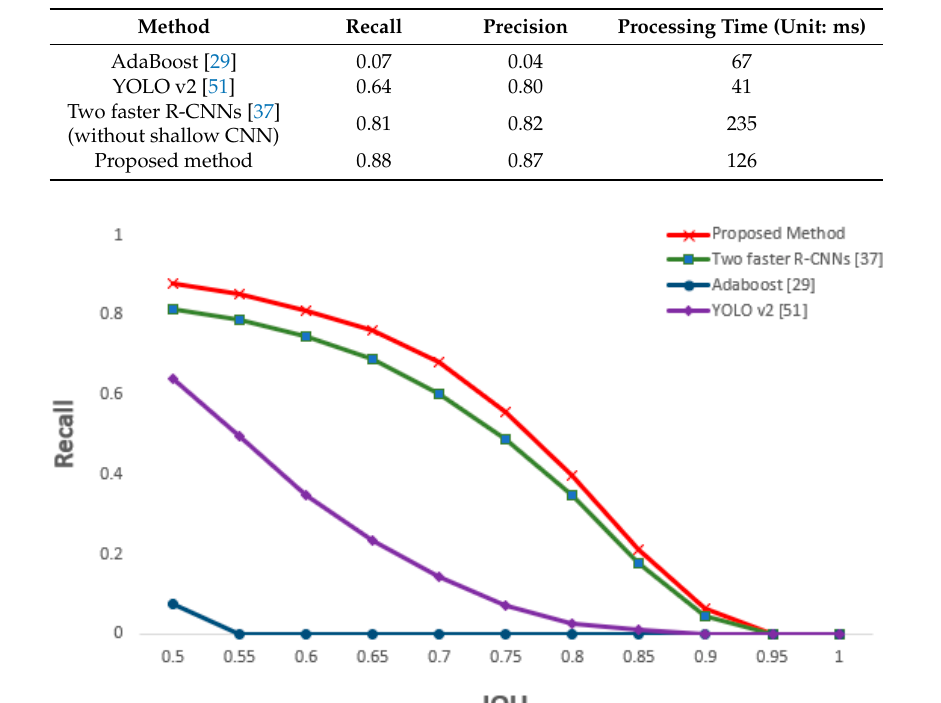
Table 11. Comparisons of recall, precision, and processing time of the proposed and previous methods at an IOU threshold of 0.5.